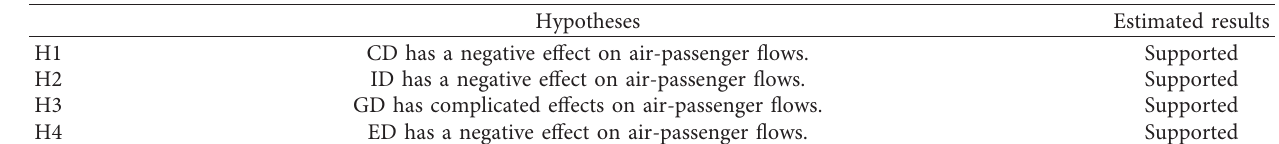
Table 13: Test results of the